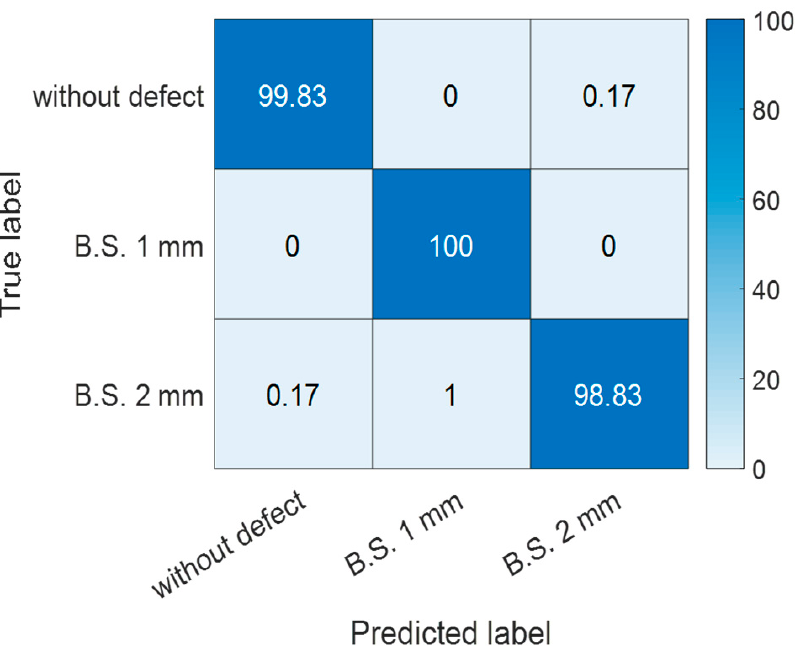
Figure 9. Defect classification accuracy of the CNN (B.S.: below surface).